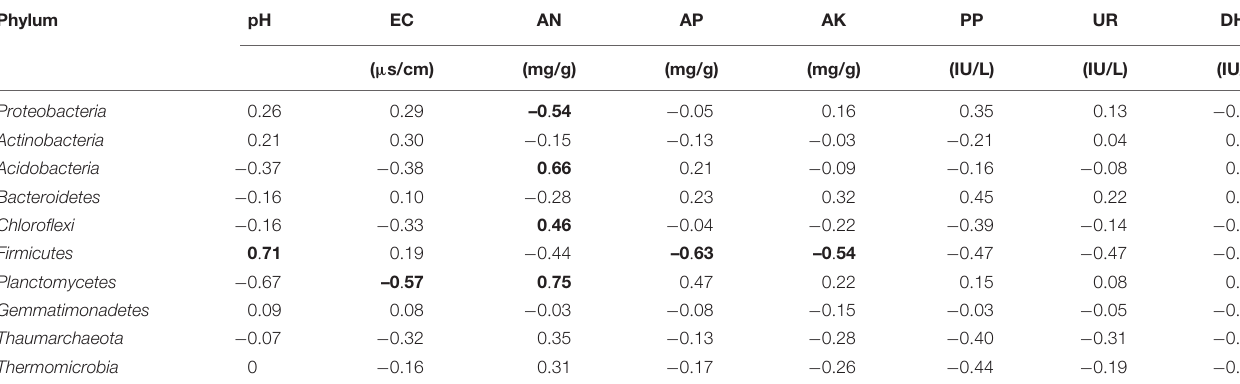
TABLE 6 | Pearson’s coefficients of correlation ( r ) between the 10 most abundant phyla of soil bacteria and soil chemical properties and enzyme activities. Phylum pH EC